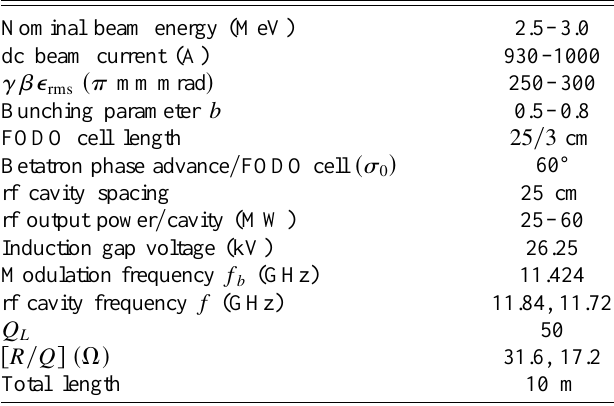
TABLE III. Main TBA